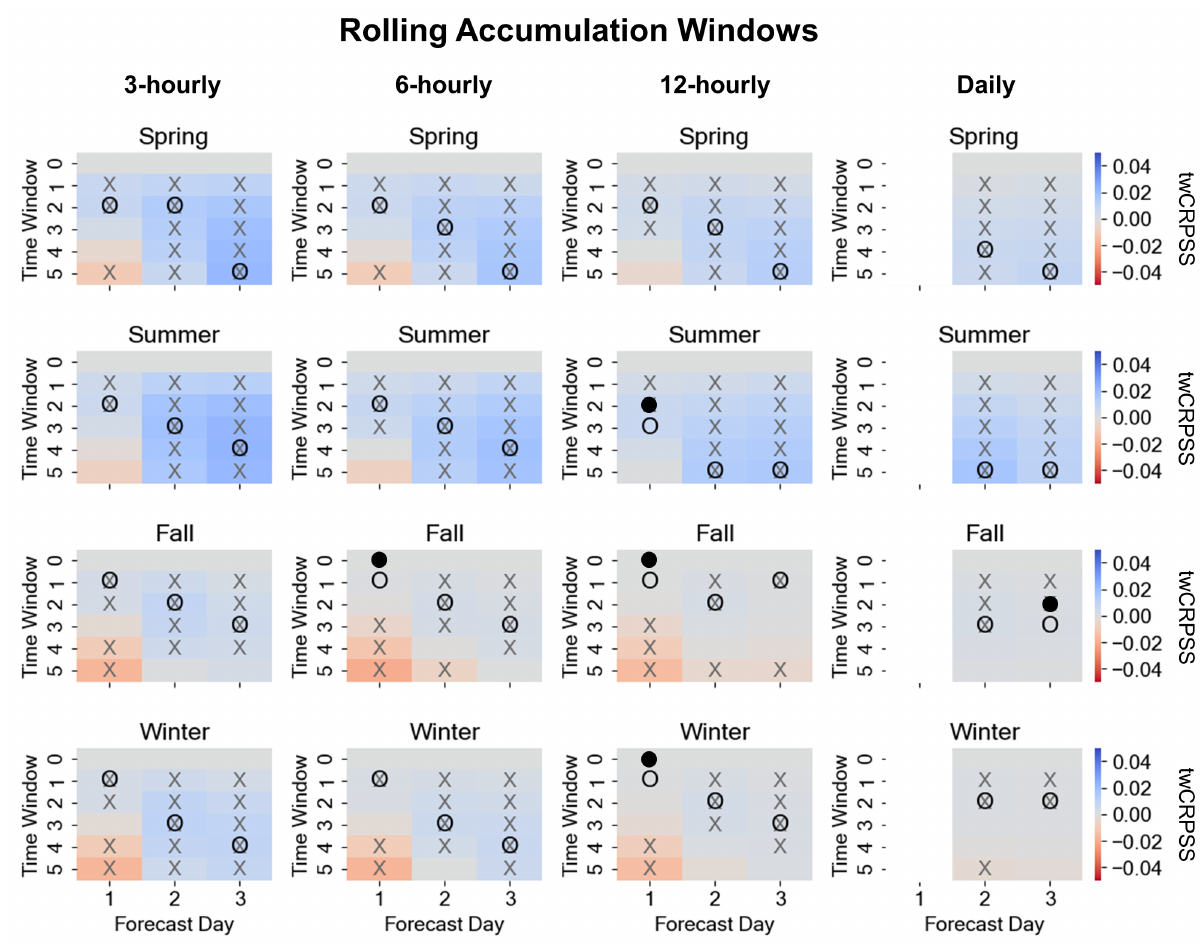
Figure 6. As in Figure 5 but for 3-hourly to daily rolling windows. Again, empty circles mark the value τ that exhibits best improvement overall, and filled circles correct the position of best τ if the value in the empty circle is not significant. Forecast day 1 for daily accumulations is removed, since it contains only 1 instead of 24 lead-time samples as on the other forecast